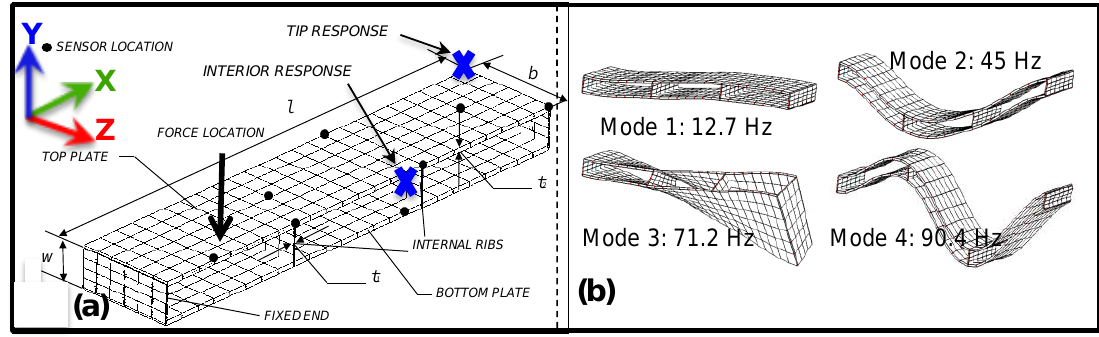
Fig. 3. (a) Box-beam model with the identification the position of force and the sparse sensors; (b) First four mode shapes of the structure.